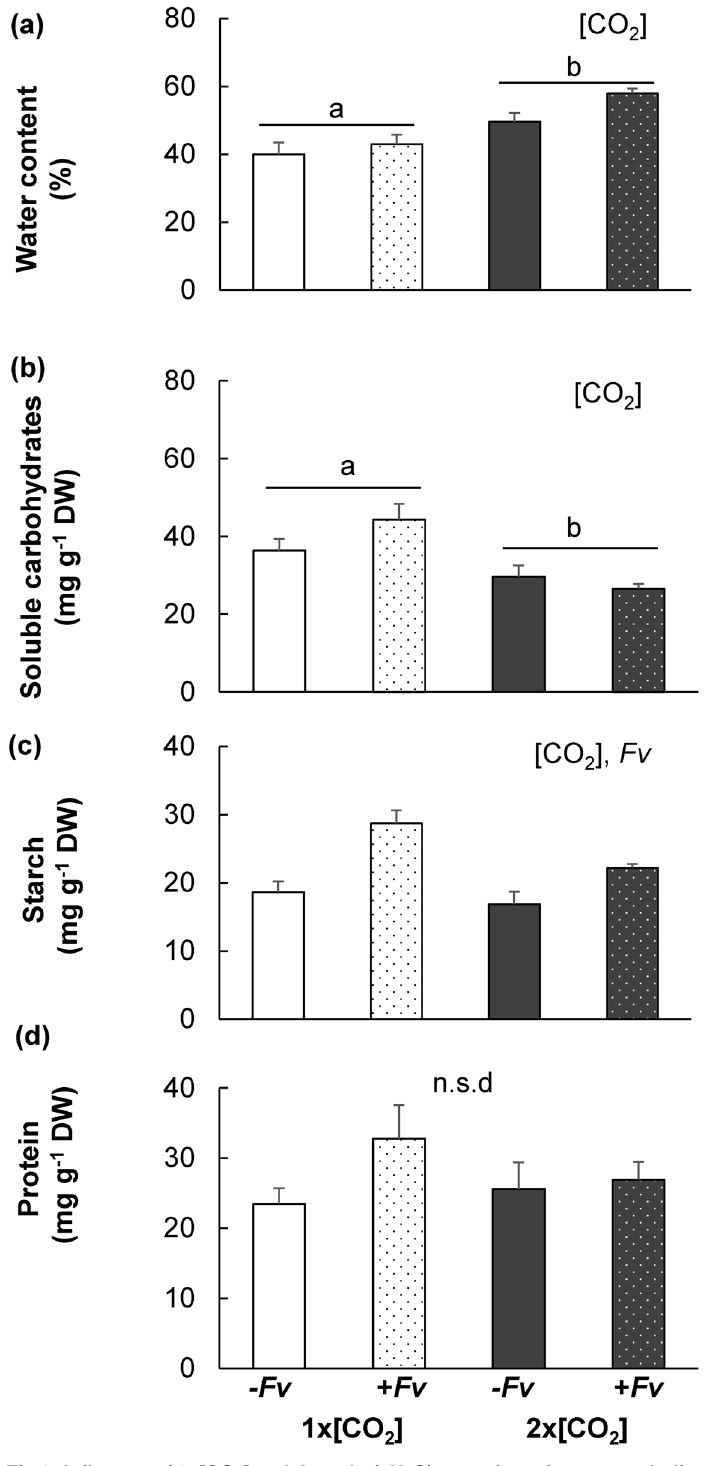
Fig 3. Influence of 2x[CO 2 ] and drought ( – H 2 O) on maize primary metabolite concentrations following F . verticillioides (Fv) inoculation. The average ± SEM (a) water content, (b) total soluble carbohydrates, (c) starch and (d) total protein in maize stems two days post mock-inoculation (- Fv ) or F . verticillioides inoculation (+ Fv ) under different [CO 2 ] and drought ( – H 2 O) was evaluated and compared. Significant contributing factors to differences are indicated in the top right hand corner of each graph (2x2 ([CO 2 ]x Fv ), ANOVA, n = 4, P <